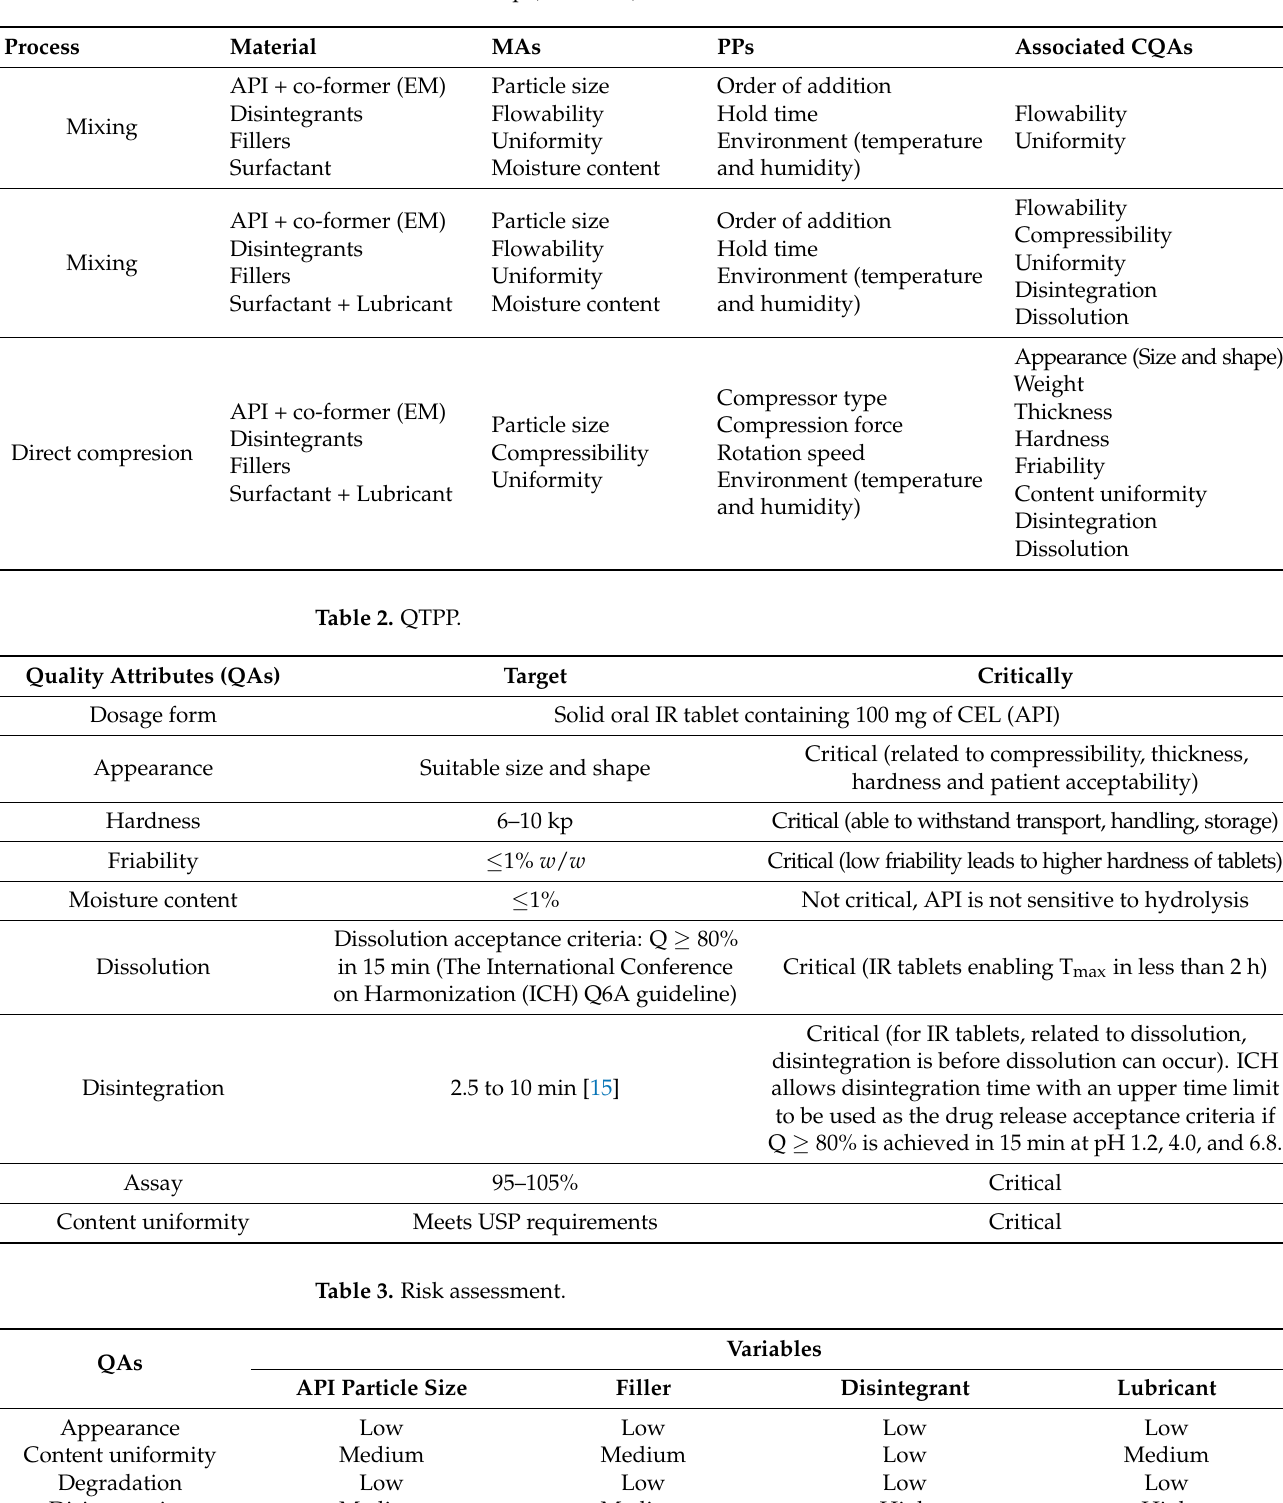
Table 1. Process Map (Lab-scale).